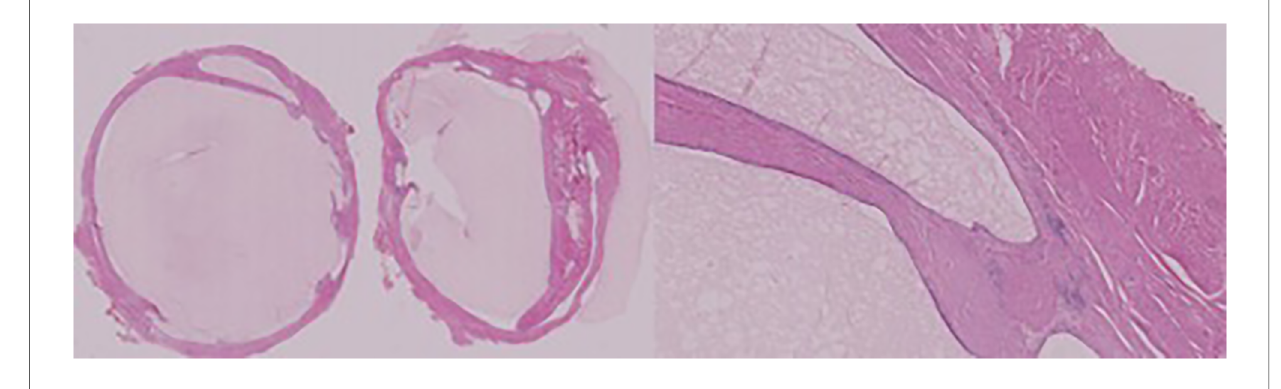
FIGURE 2 Left: EDCs; right: details of each